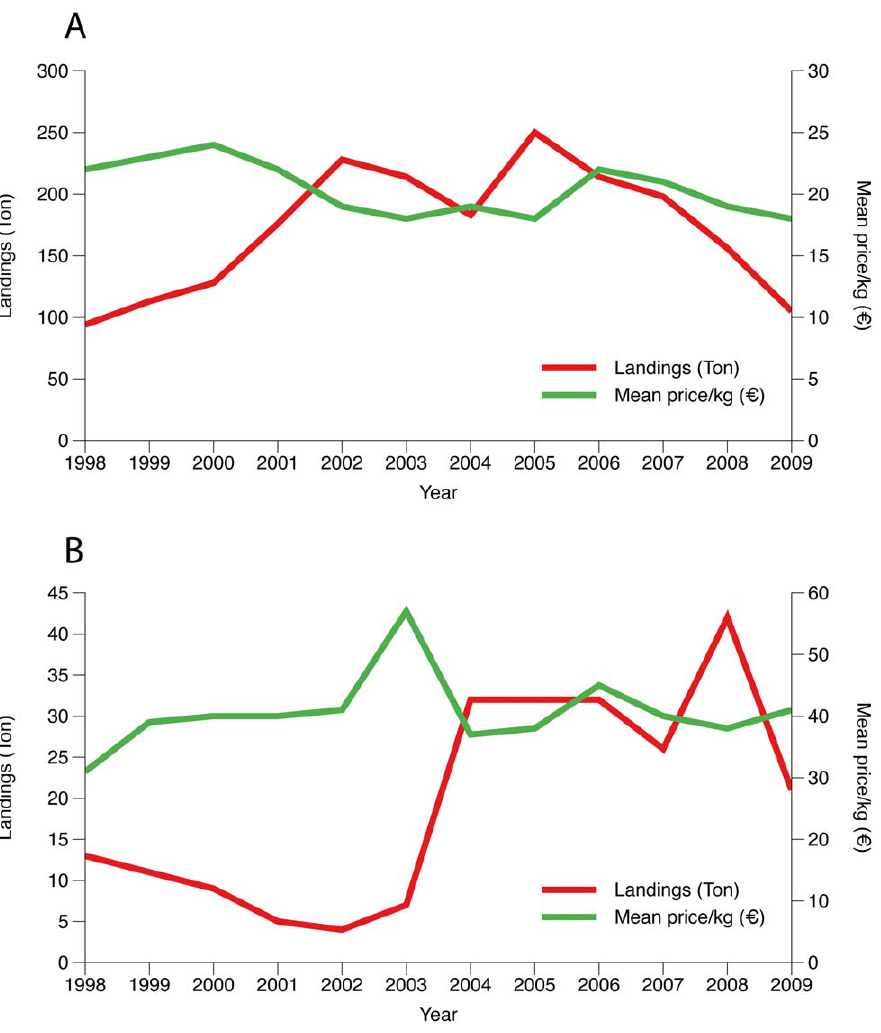
Figure 1. Evolution of the landings in weight and value. Annual landings in tons and mean price per Kg, for the trawl (A) and creel (B) fleets landing Nephrops , 1998–2007. Trawl landings exceed creel landings in weight. However, creel landings always obtained higher prices per Kg. Prices were converted from nominal to real terms using the Harmonized Index of Consumer Prices (HICP at EUROSTAT [15]).